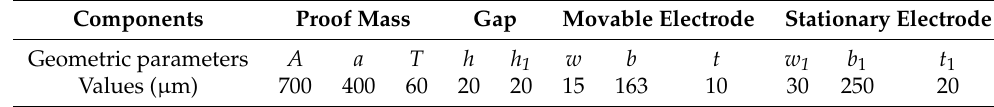
Table 1. The main geometric parameters of the designed inertial micro-switch.